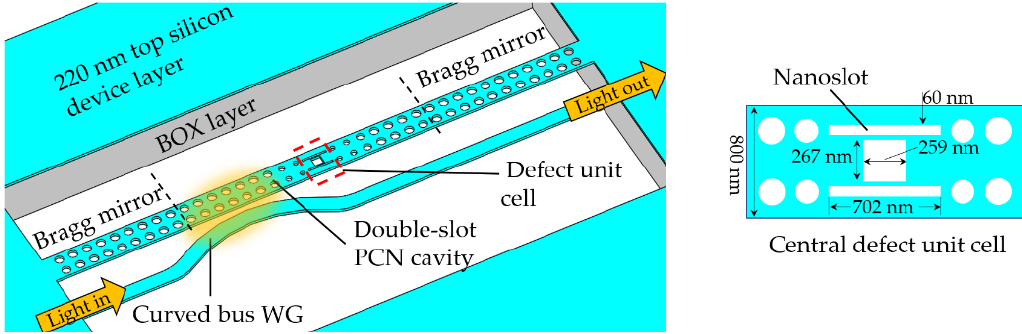
Figure 23. A femtogram scale nanomechanical resonator embedded in a double-slot PCN cavity, and the right inset is zoom-in view of central nanomechanical resonator [138] .